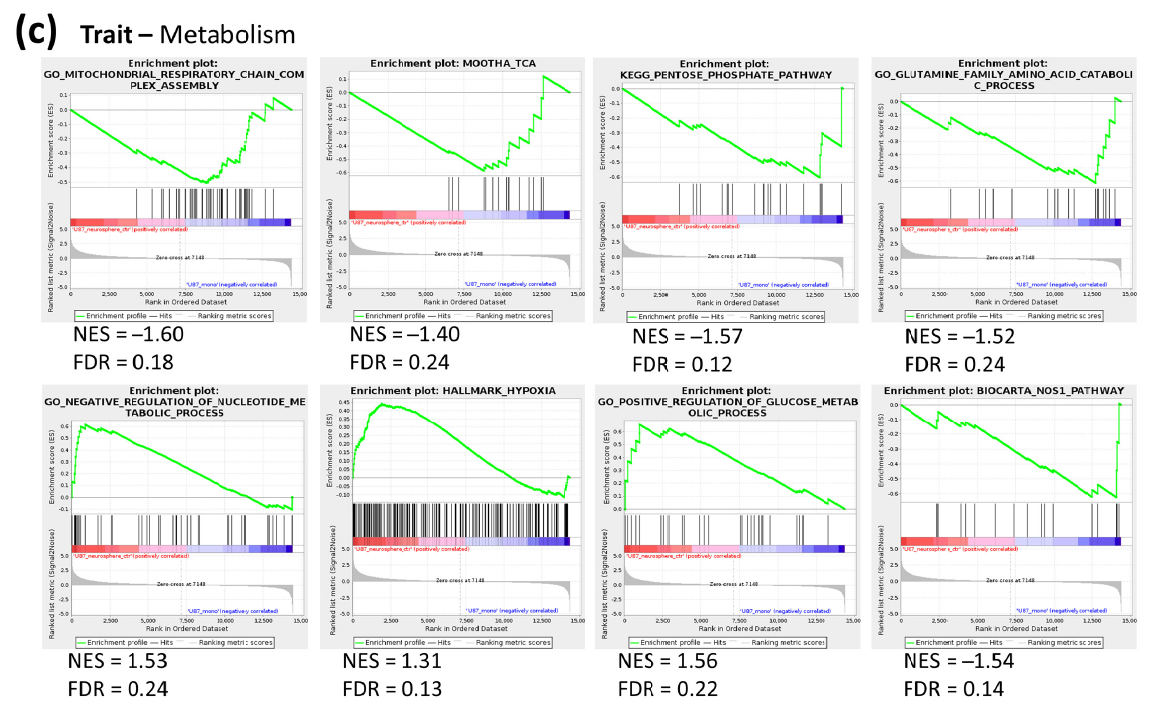
Figure 2. Gene set enrichment analysis (GSEA) of gene sets associated with stem/differentiation, proliferation/apoptosis and metabolism traits in NS vs. ML from U87 cells. ( a ) A stem cell-associated gene set is upregulated in NS, while two differentiation gene sets are enriched in ML ( b ) An apoptosis gene set is enriched, while several proliferation-associated gene sets are downregulated in NS. ( c ) Metabolism-associated gene sets, namely mitochondrial respiratory chain assembly, TCA cycle, PPP and glutamine metabolism are downregulated in NS, while a gene set representing negative regulation of nucleotide metabolism is upregulated. Hypoxia and glucose metabolism gene sets are upregulated, while a nitric oxide pathway gene set is downregulated in NS; n = 3, FDR < 0.25.